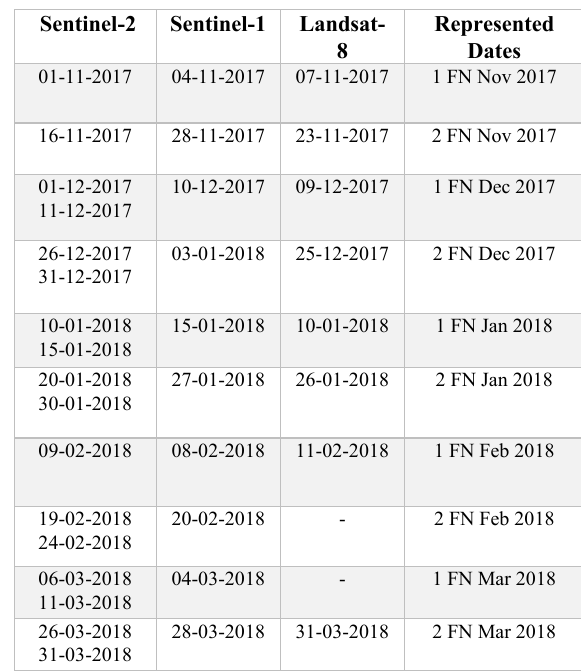
Table 1: Satellite datasets and date of pass over study region